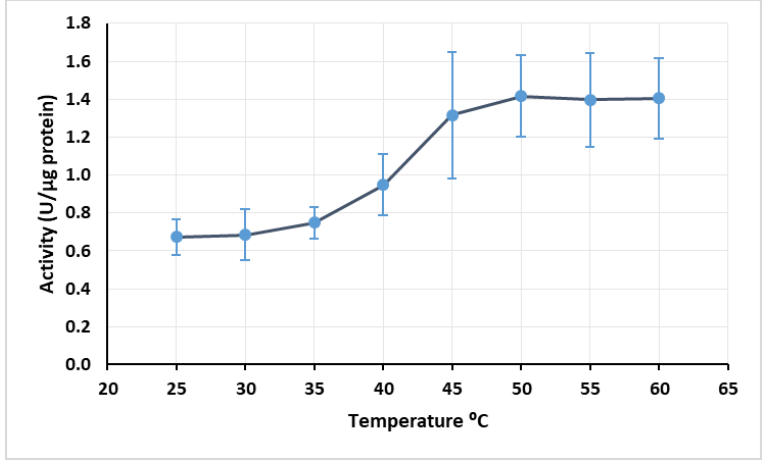
Figure 3. Effect of temperature on enzymatic extract activity at pH 4.5. Error bars represent standard deviation.